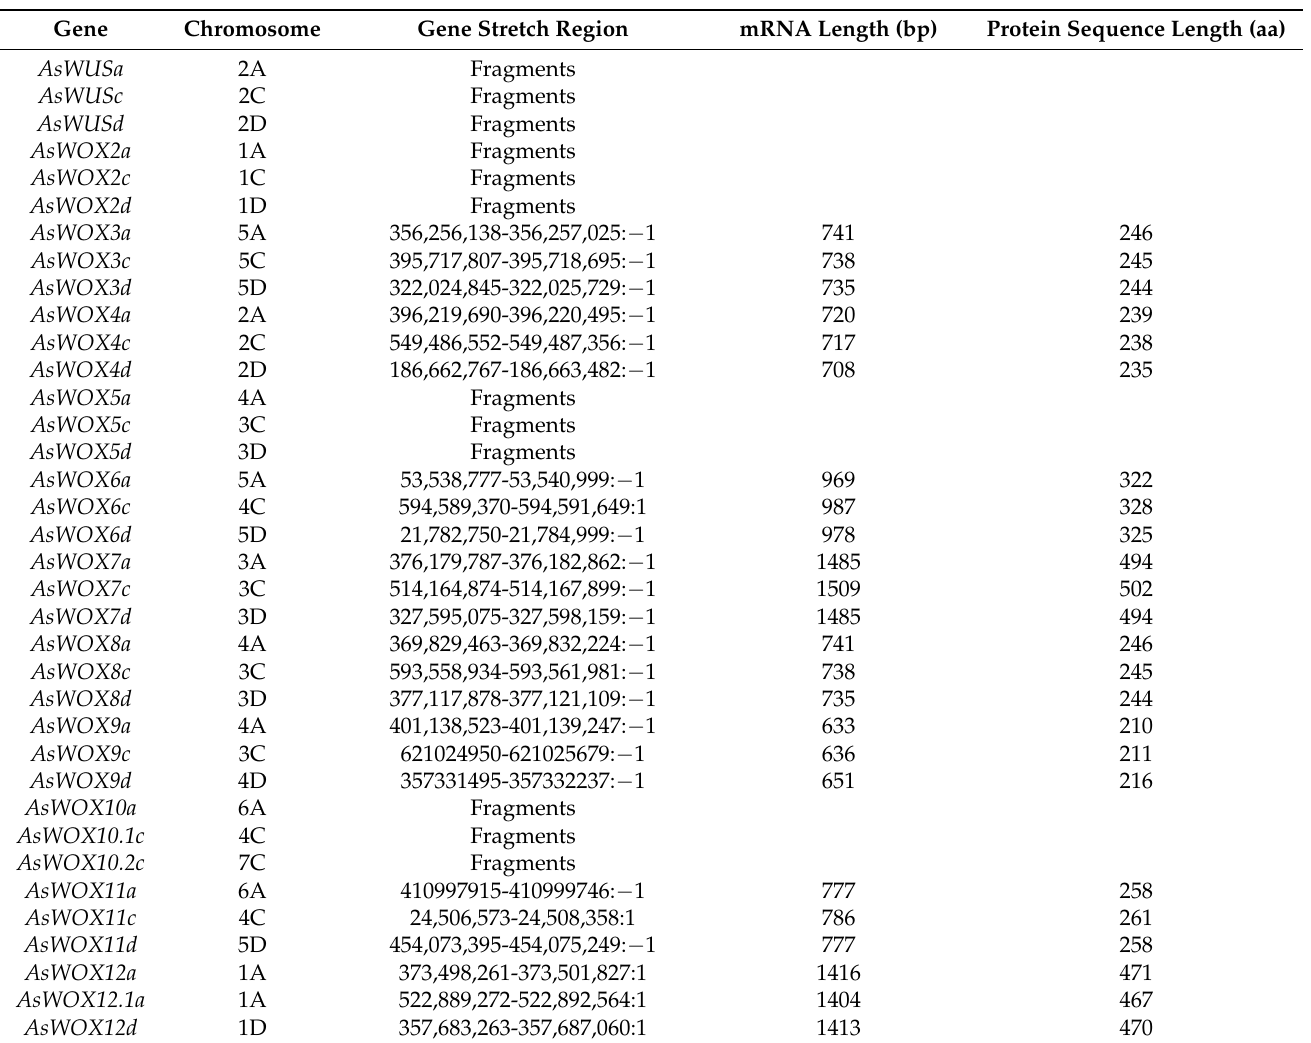
Table 5. Characteristics of AsWOX gene family members in A. sativa .